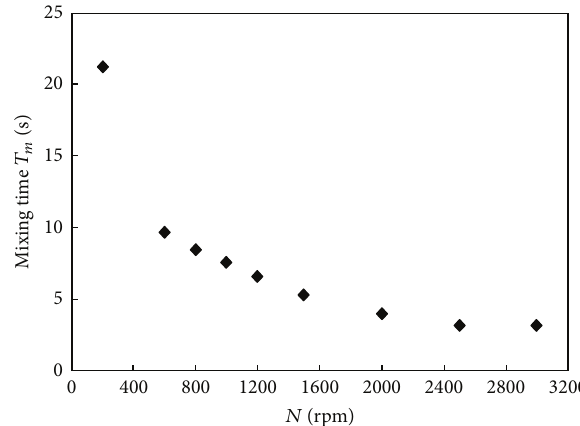
Figure 3: Correlation of the mixing time with the impeller speed by Pramparo et al. 2008